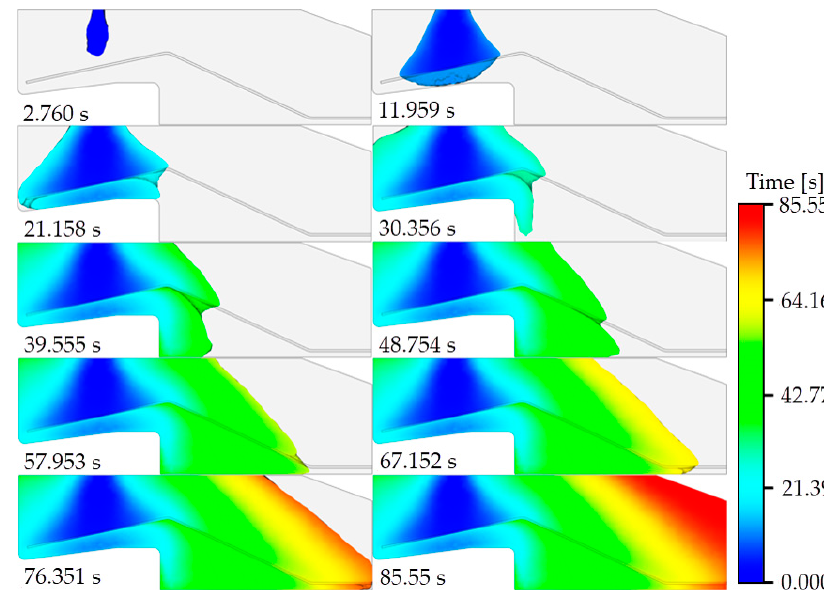
Figure 8. The resin filling process in the single steel wire pouring simulation.